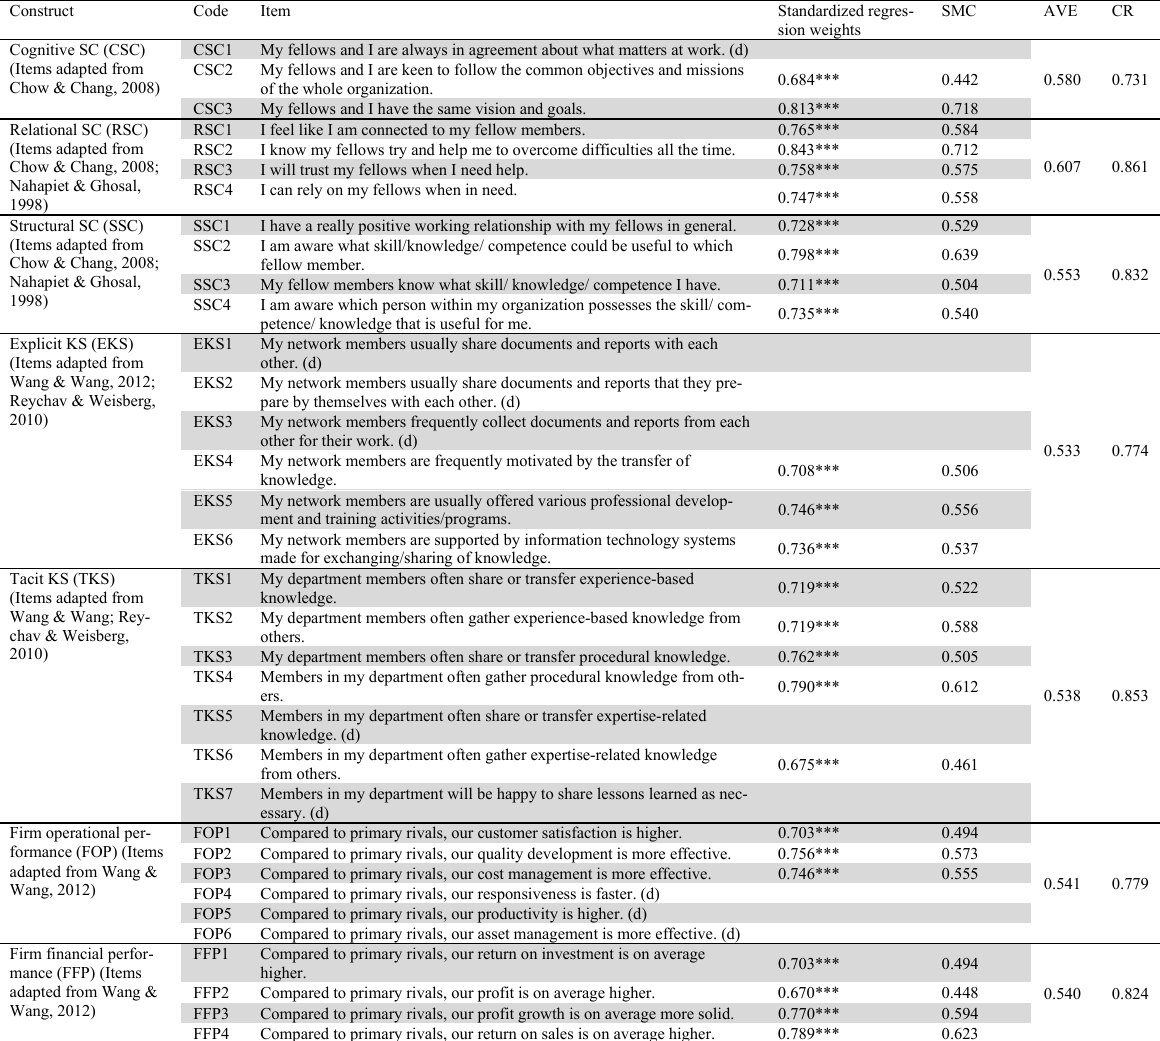
Table 1 Constructs and their measurement items Construct Code Item Standardized regres-